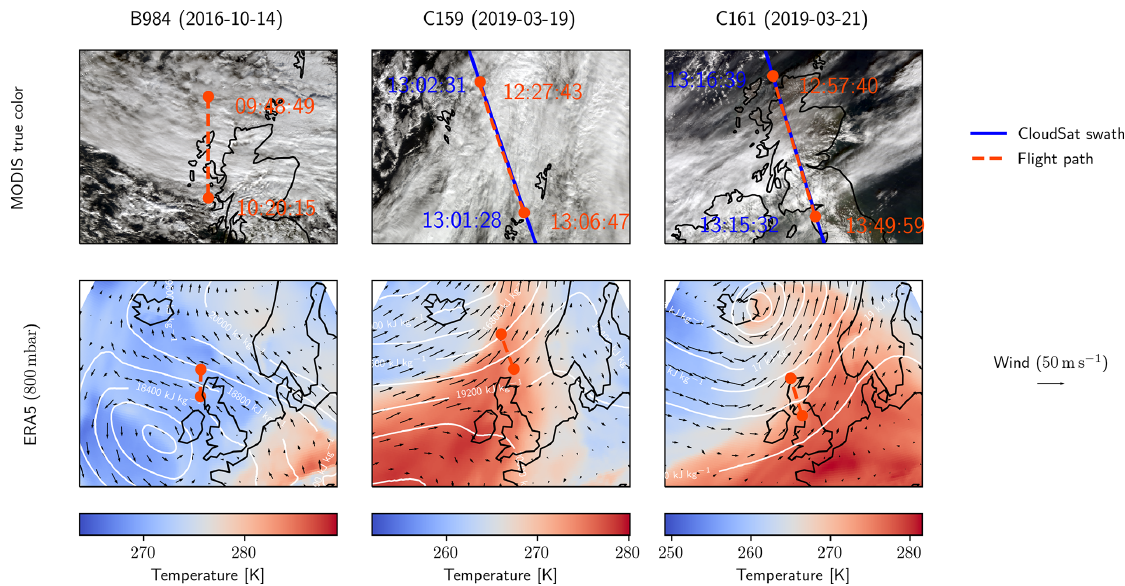
Figure 1. Flight paths of the cloud overpasses considered in this study. First row of panels shows the true-color composite derived from the closest overpasses of the MODIS (MCST, 2017) sensor on board the Aqua satellite. Second row shows ERA5 temperature (colored background), geopotential (contours) and wind speed (arrows) at the 800mb pressure level from Hersbach et al. (2018).